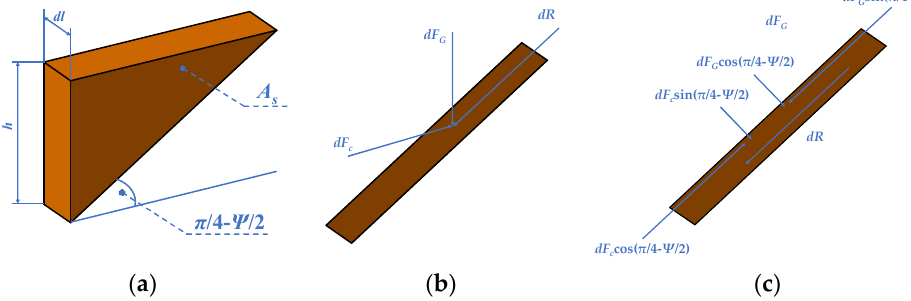
Figure 10. Force of unit soil wedge. ( a ) Unit soil wedge; ( b ) section of unit soil wedge; ( c ) force decomposition in the vertical and parallel slip plane.